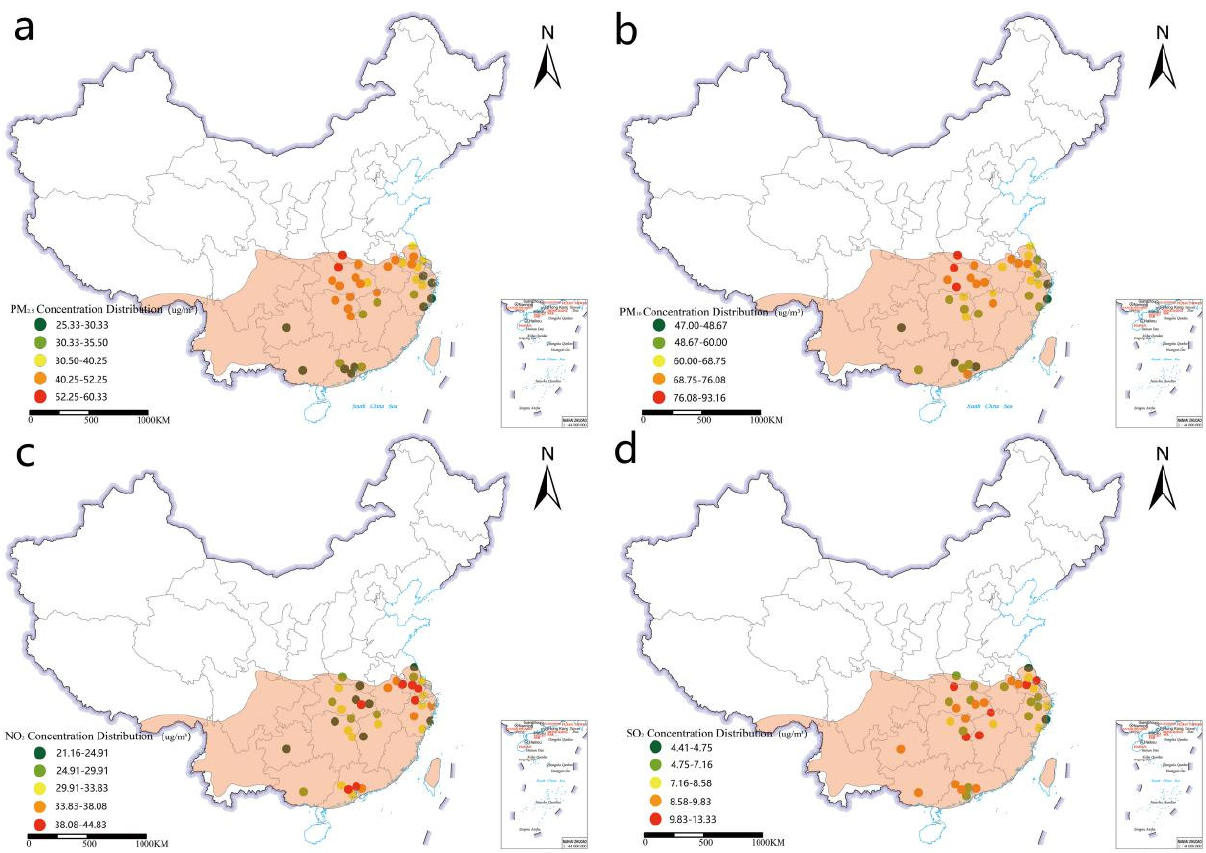
Figure 6. Distribution map of PM 2.5 , PM 10 , NO 2, and SO 2 concentration. ( a ) Distribution map of PM 2.5 concentration in the study city. ( b ) Distribution map of PM 10 concentration in the study city. ( c ) Distribution map of NO 2 concentration in the study city. ( d ) Distribution map of SO 2 concentration in the study city).